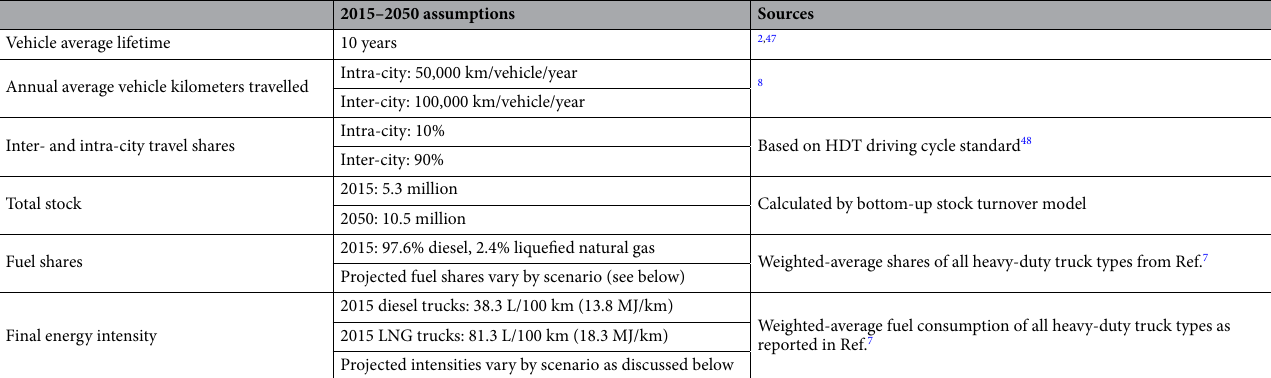
Table 1. Key assumptions for heavy-duty truck activity and energy projections.